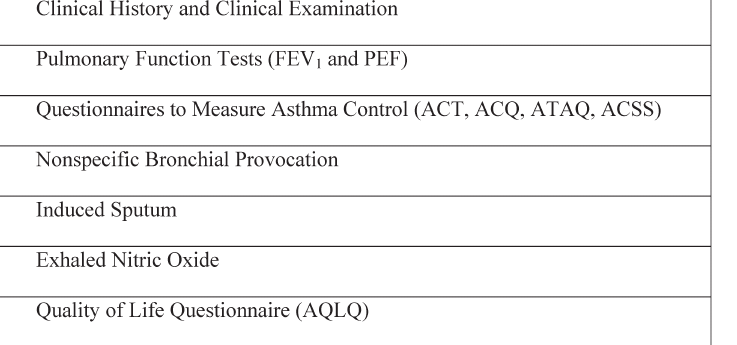
Figure 5 - Assessment of asthma control. FEV 1 : forced expiratory volume in one second; PEF: peak expiratory flow; ACT: asthma control test; ACQ: asthma control questionnaire;